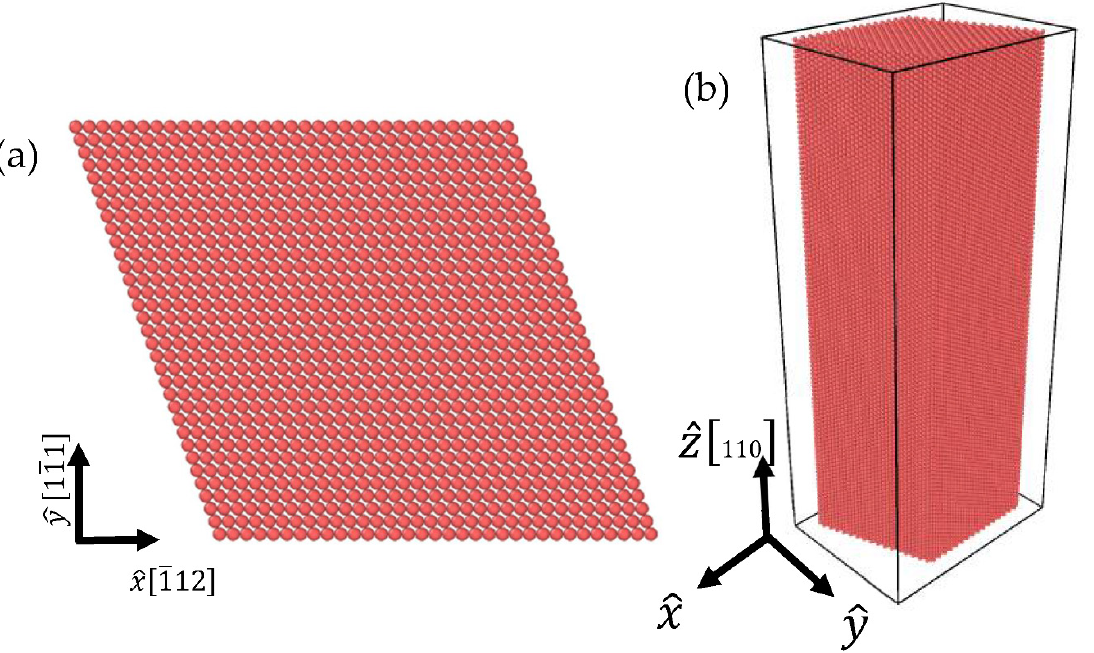
Figure 1. The unrelaxed shape of the Pd nanowire in the MD simulations. ( a ) The rhombic cross ‐ section. ( b ) a 3D view of the nanowire. The frame is the MD computational cell. section. ( b ) a 3D view of the nanowire. The frame is the MD computational